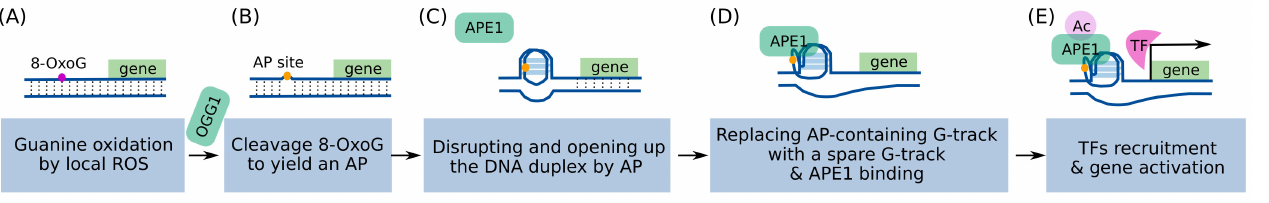
Figure 2. Proposed mechanism of G4/BER-mediated transcriptional activation. ( A ) Local ROS generates 8-OxoG in the G-rich regions of the promoter, ( B ) which is removed by OGG1 to form an AP site. ( C ) The AP site rearranges the DNA duplex into a G4 structure, and ( D ) a more stable G4 can be formed by involving the fifth G track and looping out the AP site. ( E ) APE1 can bind the AP site and recruit